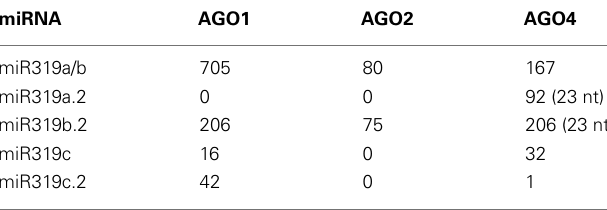
Table 2 | Detection of miR319 a/b/c and additional sRNAs from miR319a/b/c precursors withinAGO1,AGO2, andAGO4